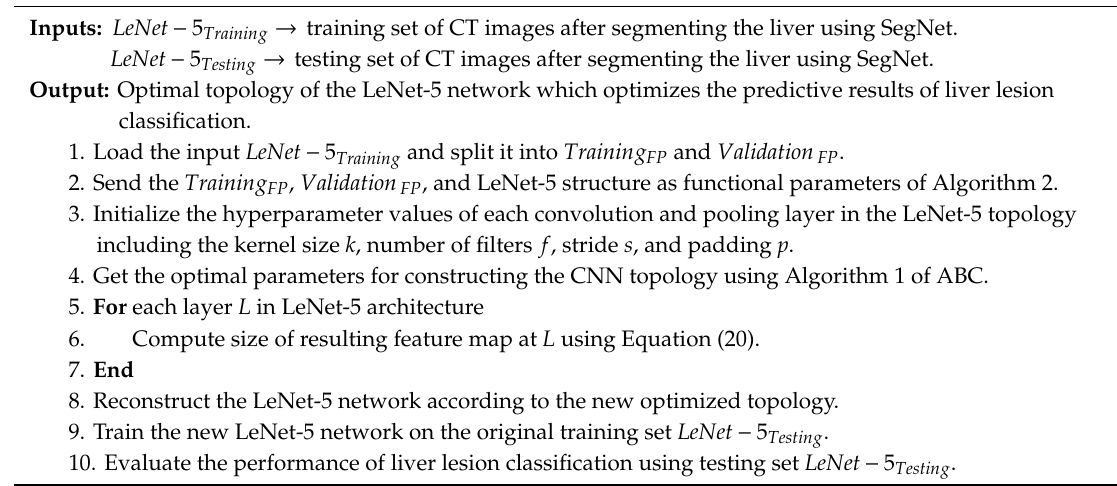
Algorithm 3: The proposed hybrid LeNet-5 / ABC for liver lesion classification.